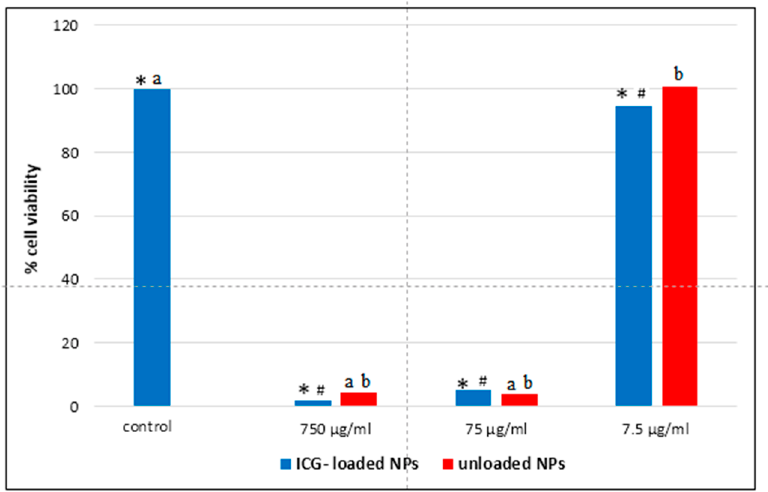
Figure 5. MTT test of ICG-loaded NPs and unloaded NPs against Caco-2 cells. ICG-loaded NPs: p < 0.05: * control vs. 750, 75, and 7.5 µg/mL; # 7.5 µg/mL vs. 750 and 75 µg/mL; unloaded NPs: p < 0.05: a control vs. 750 and 75 µg/mL; b 7.5 µg/mL vs. 750 and 75 µg/mL.